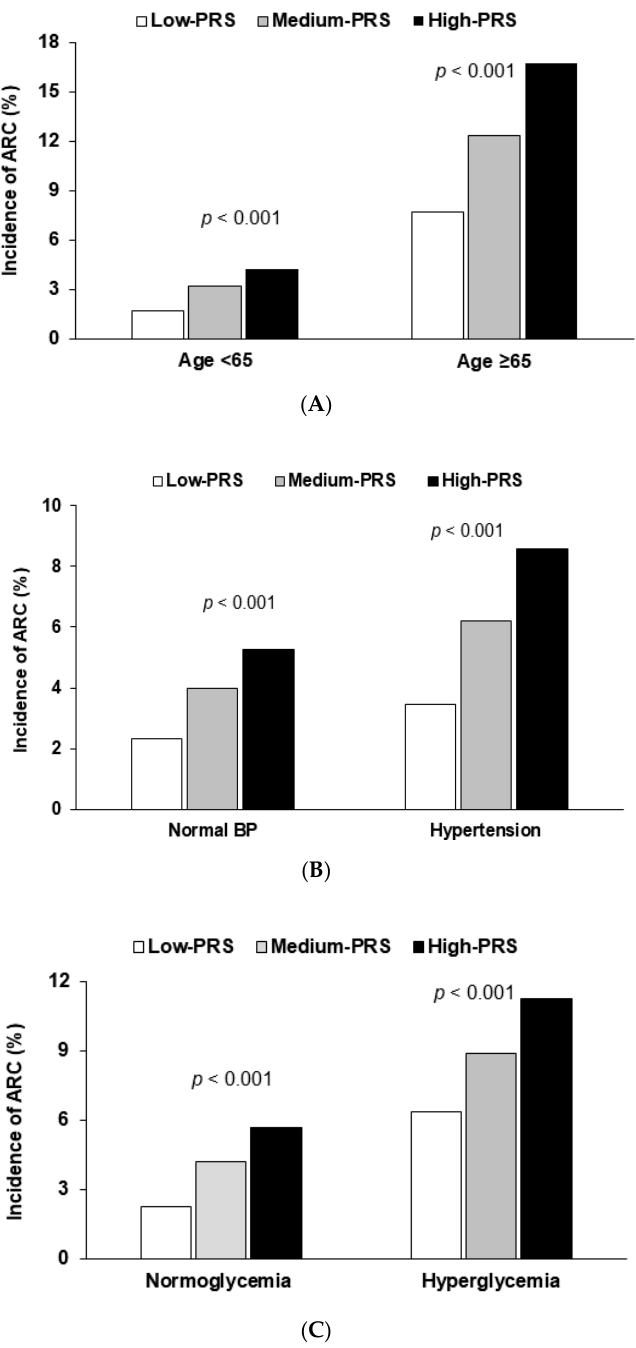
Figure 2. Age-related cataract (ARC) incidence among participants in the low-, medium- and high-PRS groups (defined using the 6 SNP genetic variant–genetic variant interaction model) for metabolic parameters. ( A ) In the participants, according to age (cutoff point: 65 years old). ( B ) In the participants, according to the blood pressure (cutoff point: 130 mmHg for SBP and 90 mmHg for DBP). ( C ) In the participants, according to serum glucose concentrations (cutoff point: 126 mg/dL serum glucose concentrations). PRS was calculated by the summation of polygenetic-risk scores of the best model with 6 SNPs and categorized into three groups (0–6, 7–9, and ≥ 10) by the tertiles (low-PRS, medium-PRS, and high-PRS). p -values represent the significance of di ff erences among the PRS groups by χ 2 test in each